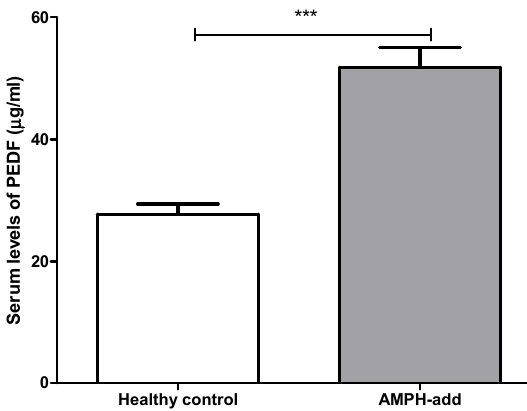
Figure 2. Comparison of PEDF serum level between AMPH-add and control. Data are expressed as mean ± standard error. Statistical analysis was carried out using unpaired Student’s t -test. ***: statistically significant at p < 0.001.